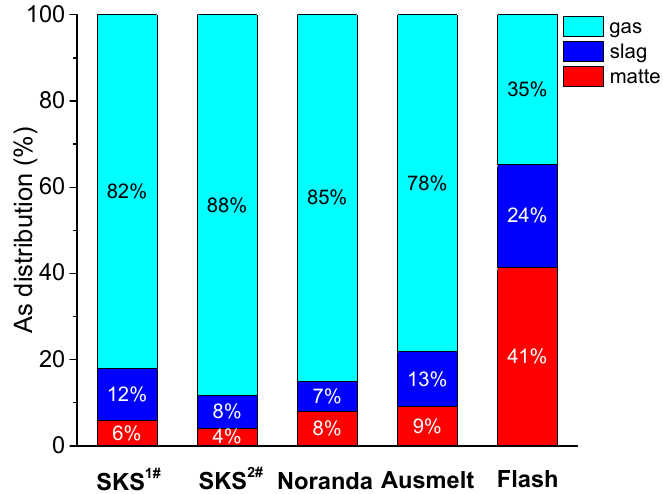
Figure 5. Distribution of arsenic in different smelting processes. SKS 1# : industrial data of SKS process with matte grade 70% in Dongying Fangyuan Smelter; SKS 2# : industrial data of SKS process with matte grade 50% in Yantai Hengbang Smelter.